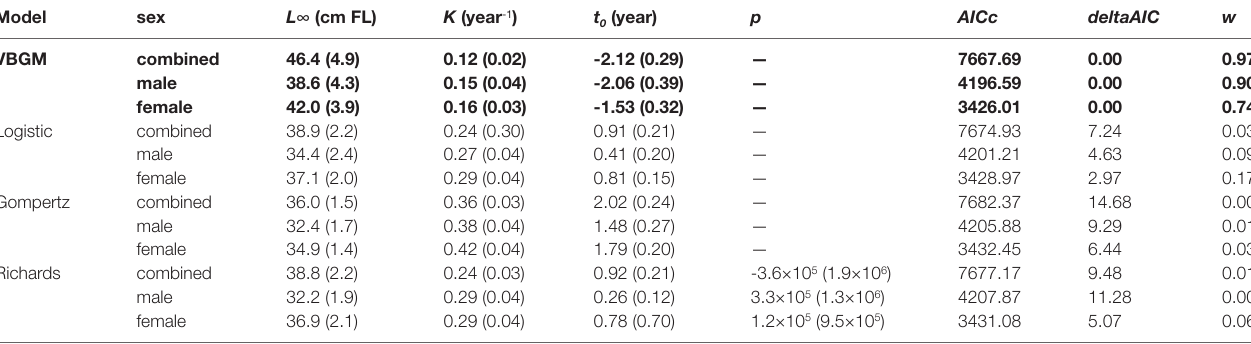
TABLE 4 | Parameter estimates (± standard error) from four candidate growth models, by sex, for the brushtooth lizardfish off Taiwan. Model